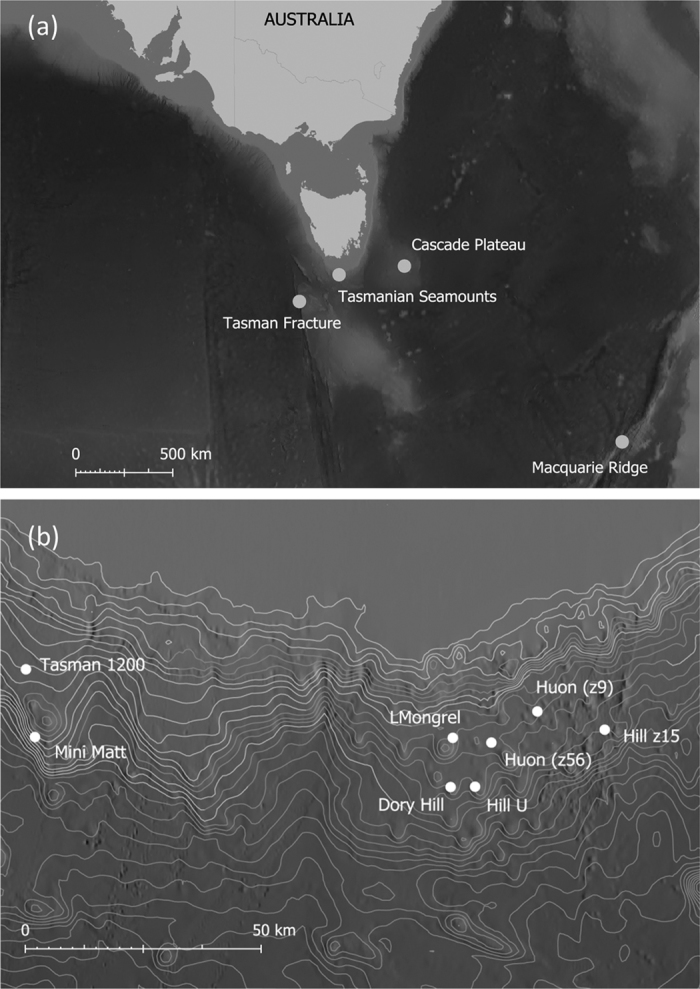
Map of four sampling regions (a) for the two deep sea coral species Desmophyllum dianthus and Solenosmilia variabilis in the Southern Ocean and details of individual seamounts (b) sampled within the Tasmanian Seamounts complex, noting five replicate sites were sampled on each of Mini Matt and Hill U seamounts. Maps were generated using Manifold GIS (V8.29) www.manifold.net based on the publically available Australia Bathymetry and Topography Grid, June 2009 obtained from Geoscience Australia (www.ga.gov.au).